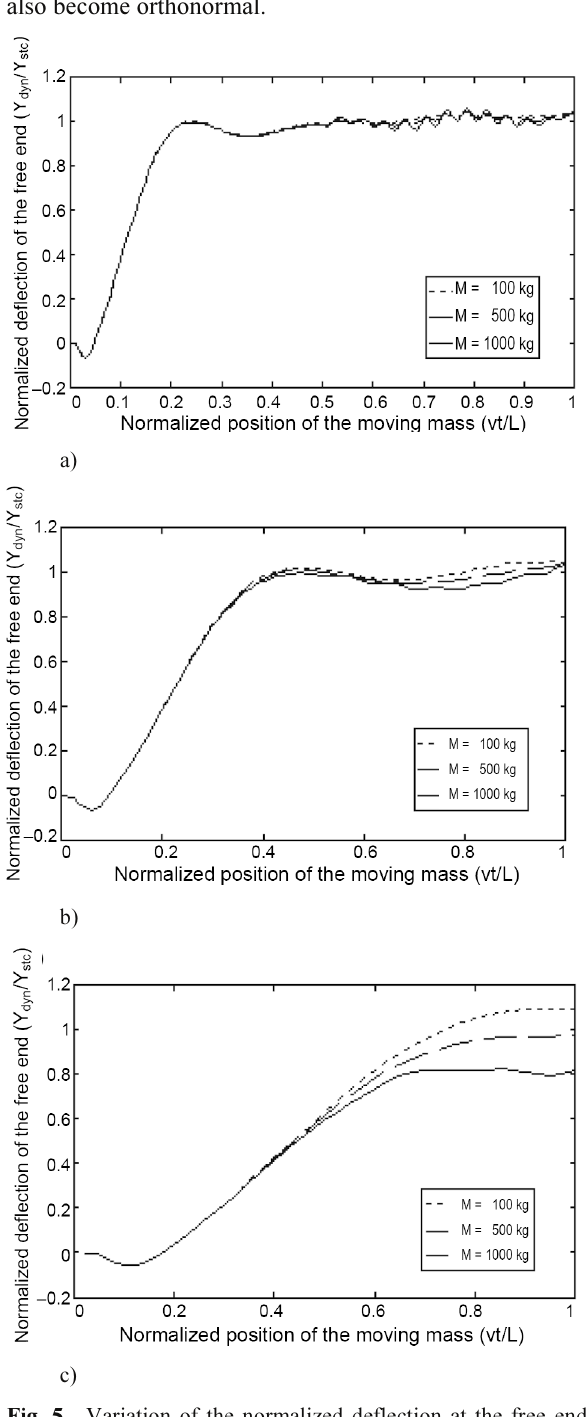
Fig. 5. Variation of the normalized deflection at the free end with respect to normalized position of moving mass for differ- ent values of the moving mass. L 0 = 4 m, γ = 0.5: a) v = 5 m/s; b) v = 10 m/s; c) v = 20 m/s